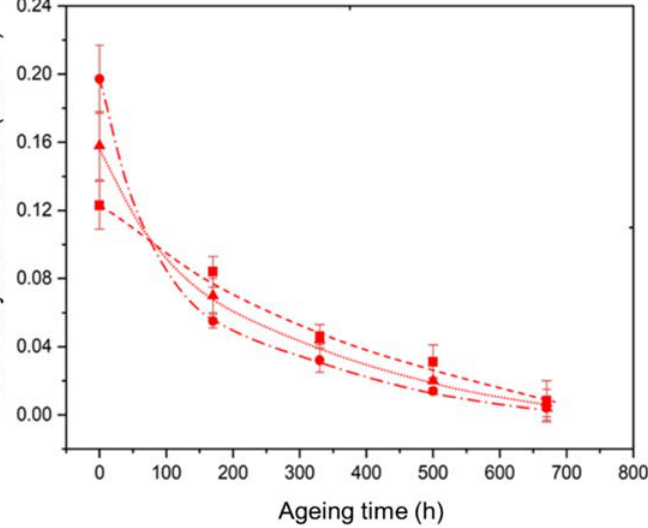
Figure 11. Changes in the concentration of elastically active chains in the Si ‐ XLPE matrix filled with 0 phr ( □ ), 25 phr ( ), and 50 phr ( ) of ATH, during its radio ‐ thermal exposure in air under 400 Gy ∙ h − 1 at 21 °C.